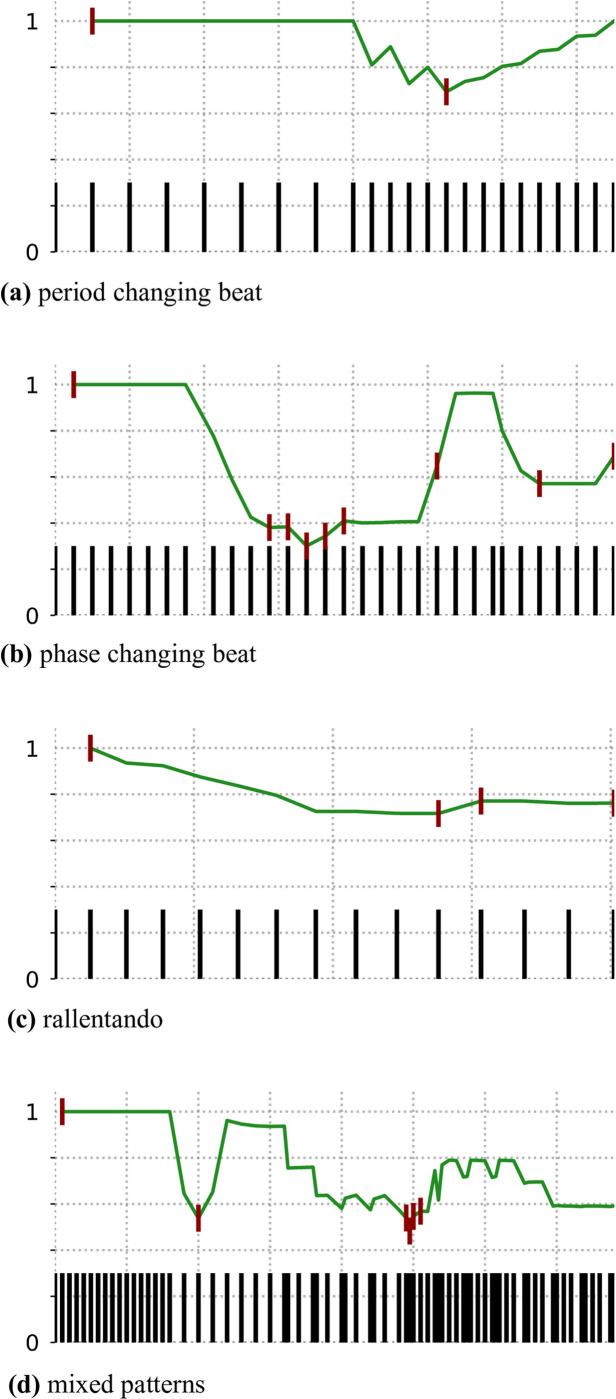
THT’s pulse clarity metric developing over synthetic rhythmic passages.The plots show the confidence of the top hypothesis over time. The X axis is time. The Y axis is the congruency score of the best hypothesis at a given time. Markers are placed each time the main hypothesis changes. At the bottom of the plot, the musical events are displayed over time.